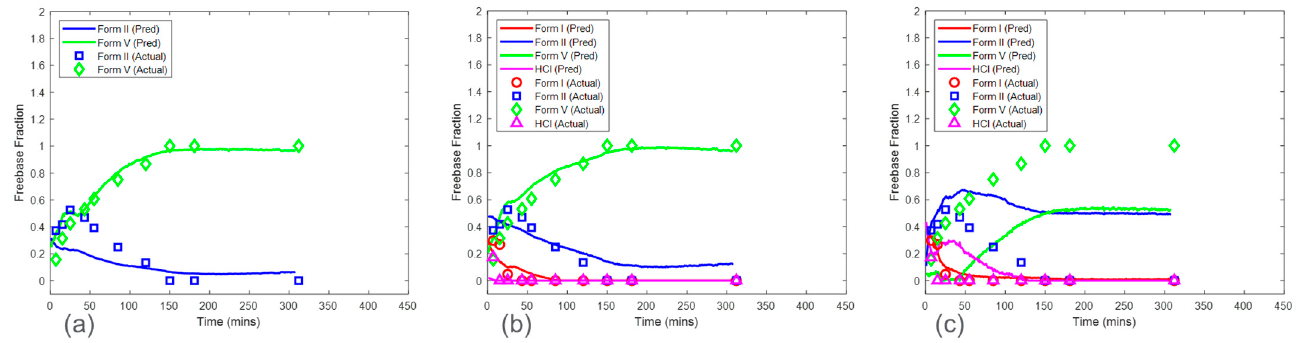
Figure 9. Model prediction on HCl salt experiments using the calibration without concentration procedure: 50 mg/mL (model set 1) ( a ), 25 mg/mL (model set 2) ( b ), and 12.5 mg/mL (model set 3) ( c ) solid concentrations. Note the relative standard deviation of XRPD reference values was approximately 4%.